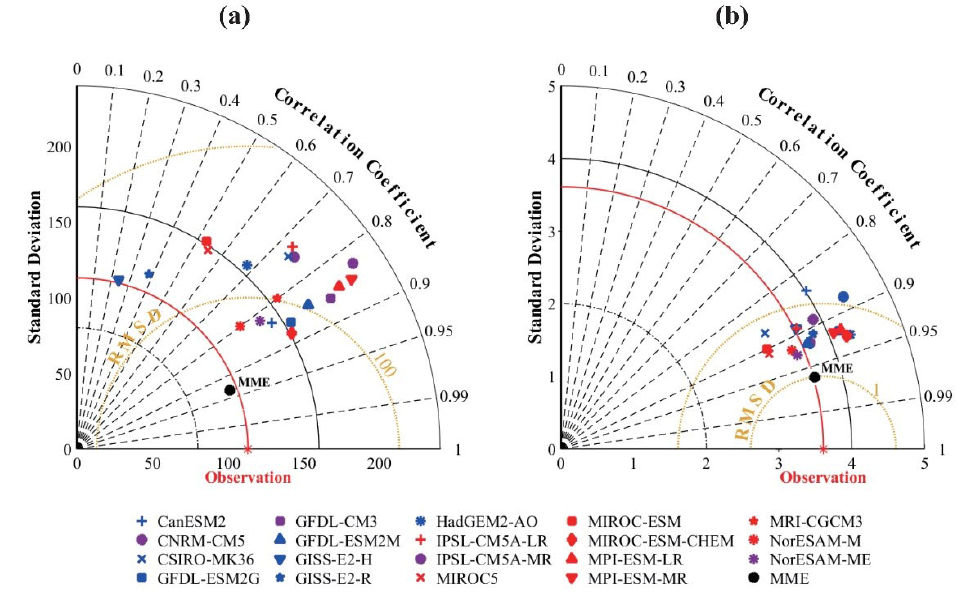
Figure 2. Taylor diagram of ( a ) precipitation and ( b ) temperature.